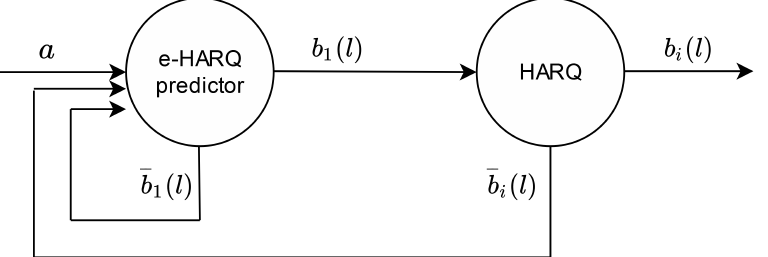
Figure 2. Structure of the model with two phases, corresponding to e-HARQ and HARQ, respectively. Here i =